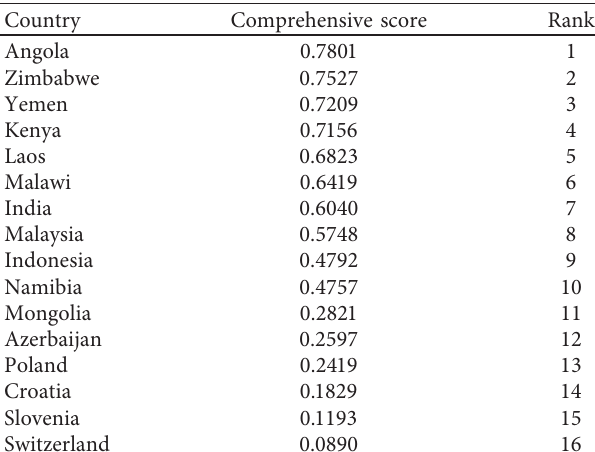
Table 3: Comprehensive score